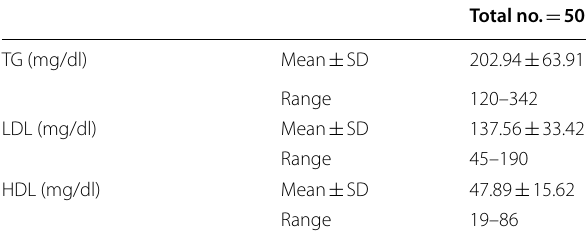
Table 2 Demographic characteristics, anthropometric measures, and laboratory investigations of the studied